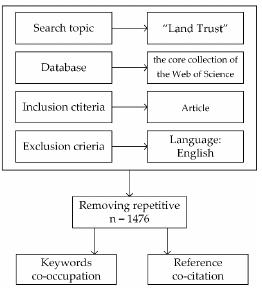
Figure 1. Flow chart for the research process.